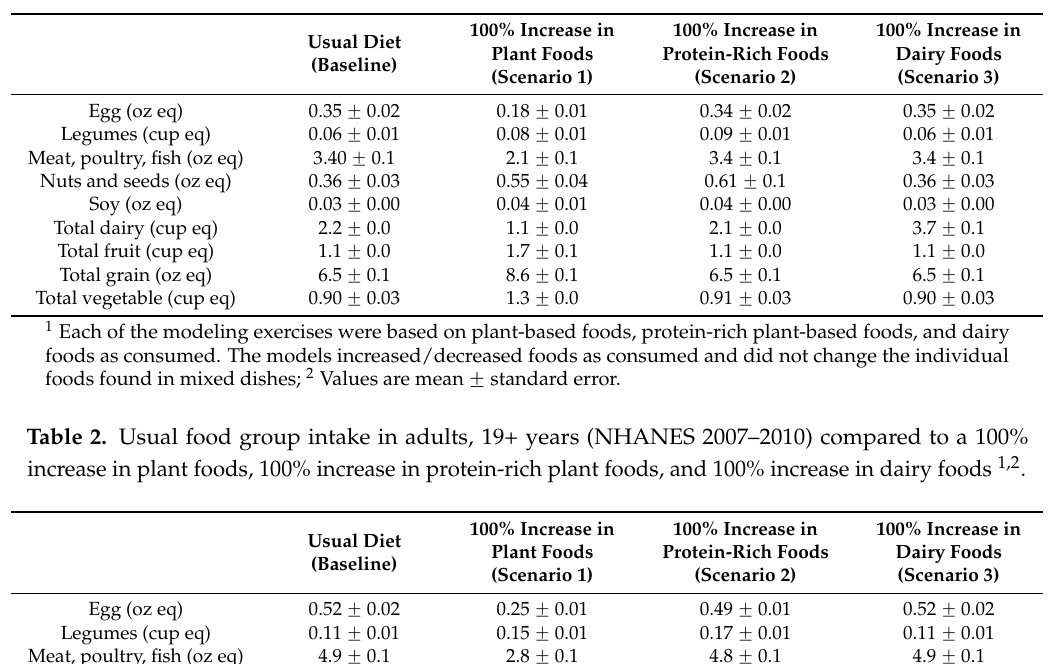
Table 1. Usual food group intake in children, 2–18 years (National Health and Nutrition Examination Survey (NHANES) 2007–2010) compared to a 100% increase in plant foods, 100% increase in protein-rich plant foods, and 100% increase in dairy foods 1,2 .